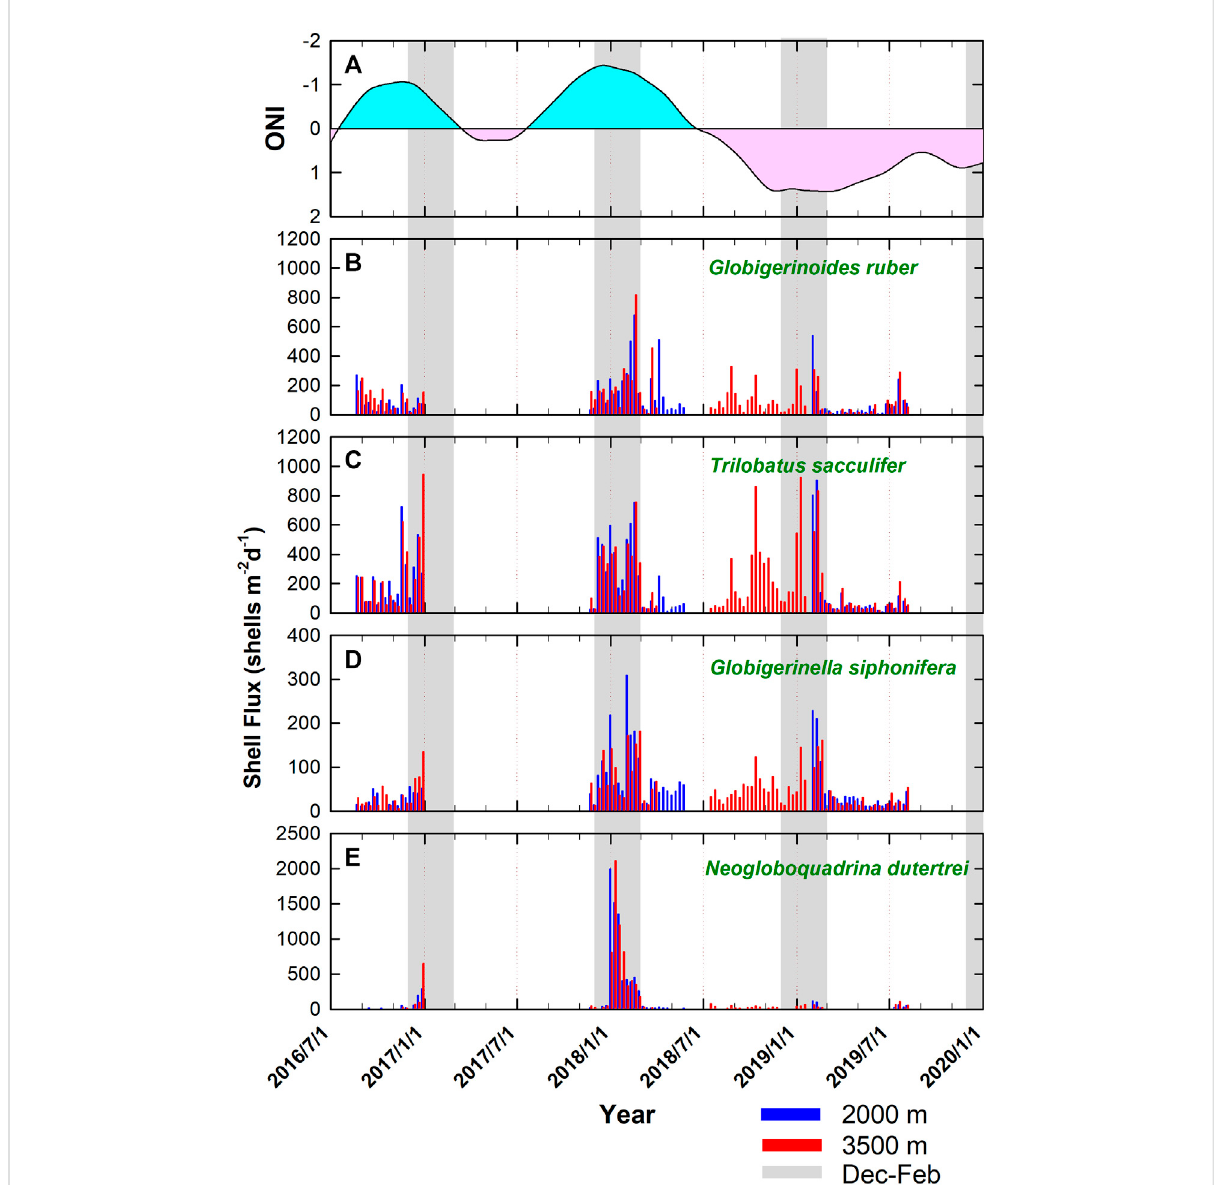
FIGURE 4 Time series of (A) ONI (pink and light blue areas refer to positive and negative values, respectively) and annual shell fl uxes (numbers of shells m − 2 · day − 1 ) for (B) Globigerinoides ruber , (C) Trilobatus sacculifer , (D) Globigerinella siphonifera , and (E) Neogloboquadrina dutertrei . Gray bars indicate the periods of December to